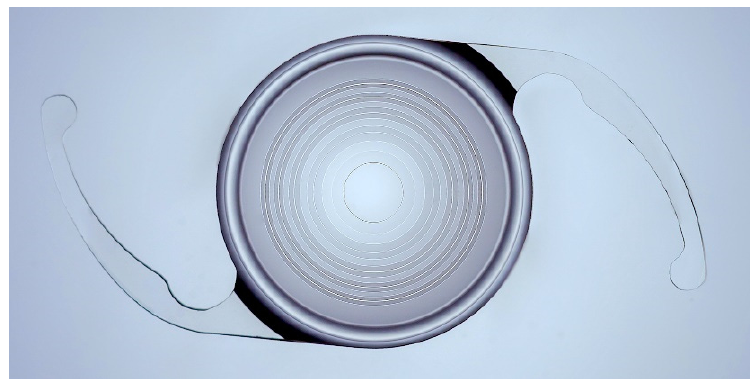
Figure 1. Asqelio TM Trifocal